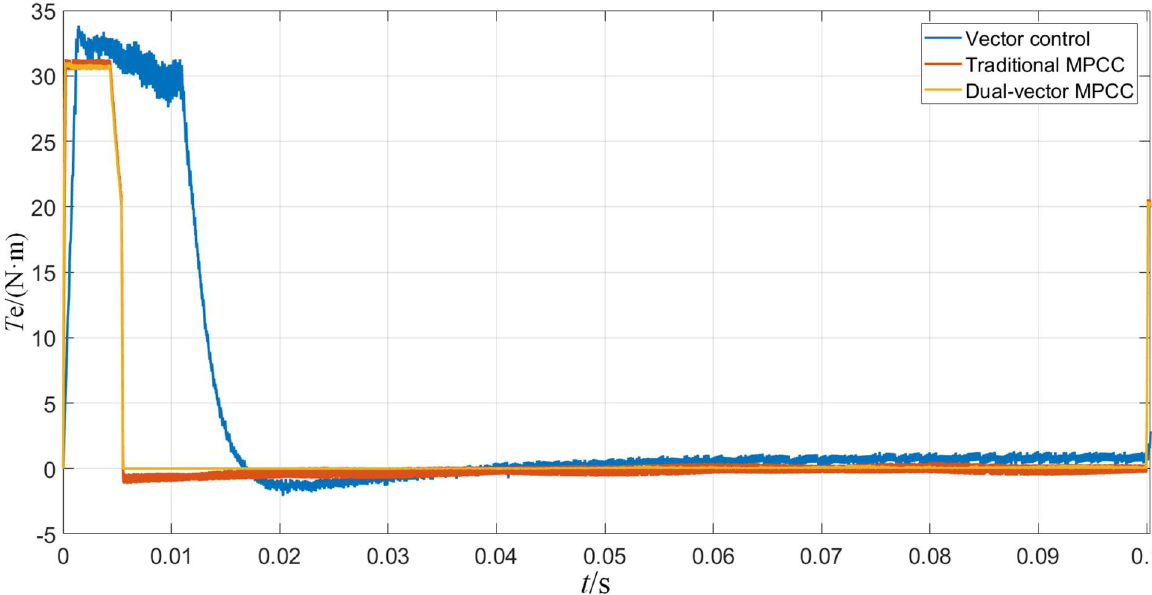
Fig 8. Torque waveform when the motor